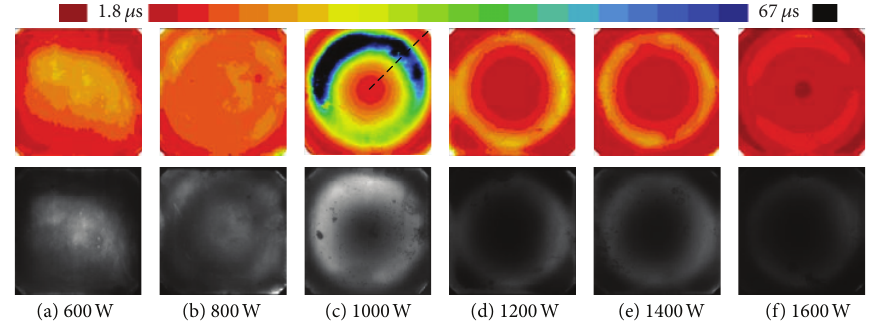
F 1: Minority carrier lifetime mappings and PL images of oxide at different sputtering powers and aer a 30min postannealing at 500 Lower row: PL images.